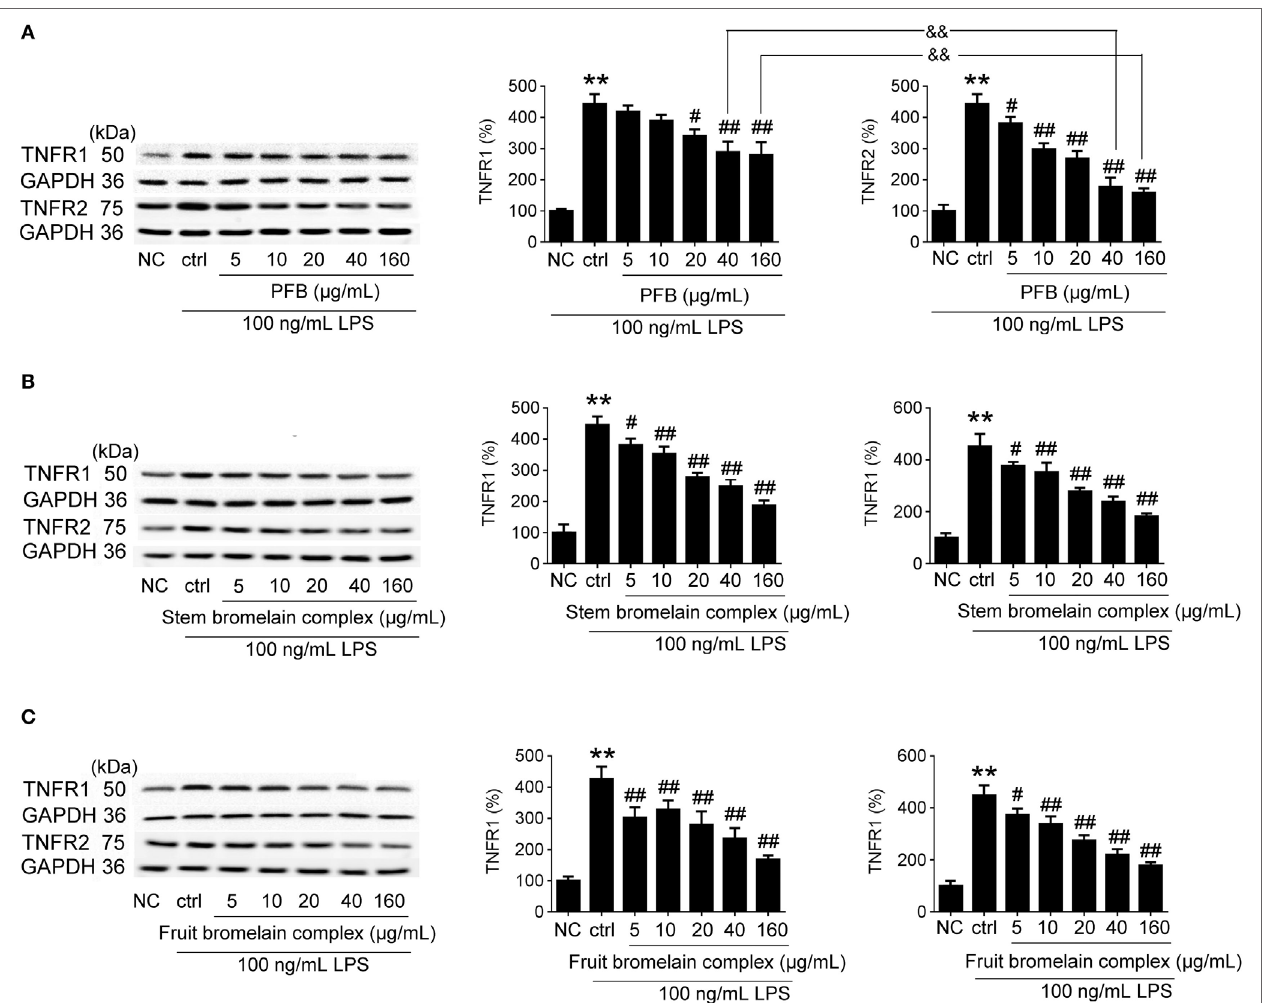
FigUre 8 | Comparative study of purified fruit bromelain (PFB) with bromelain complex. Western blotting analysis of the effects of purified PFB (a) , stem bromelain complex (B) , and fruit bromelain complex (c) on the protein expression of TNFR1 and TNFR2. Data are expressed as the mean ± SD. Values in normal control (NC) group are set to 100% and other values are given relative to those in the NC group: ** P < 0.01 compared with the NC group; # P < 0.05 and ## P < 0.01 compared with LPS control group; && P < 0.01 compared with as indicated ( n = 6